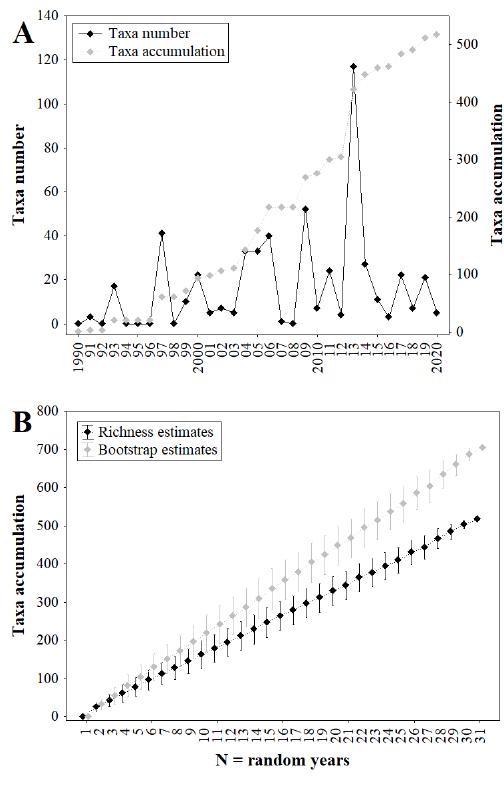
Figure 5. Number of taxa found in (A) each environment and (B) substrate type in all papers analysed.